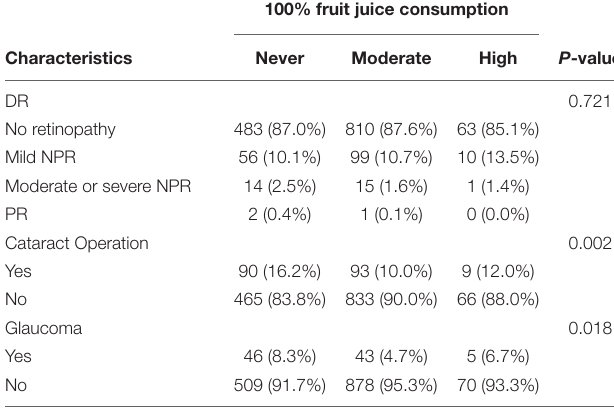
TABLE 3 | Multi-class logistic regression model of the association between AMD and 100% fruit juice consumption.